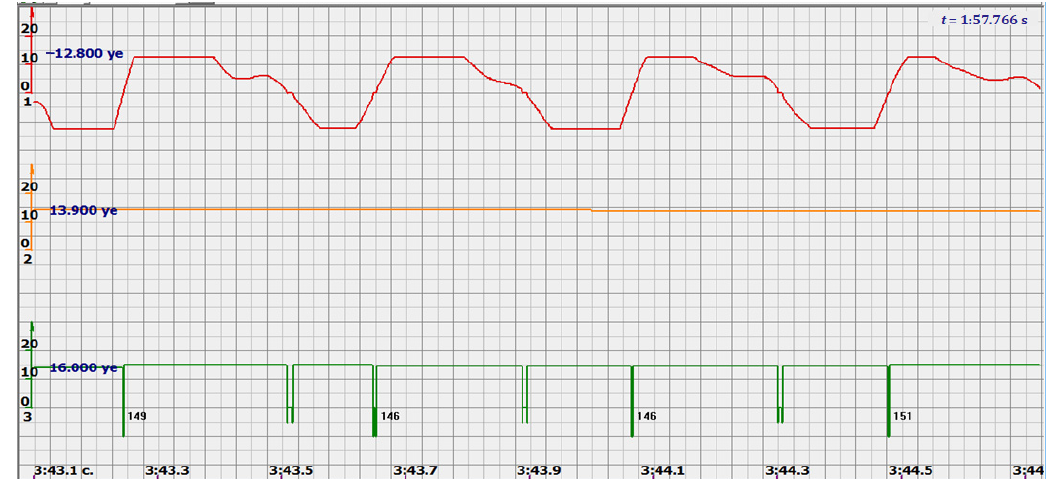
Sensors 2022 , 22 , x FOR PEER REVIEW